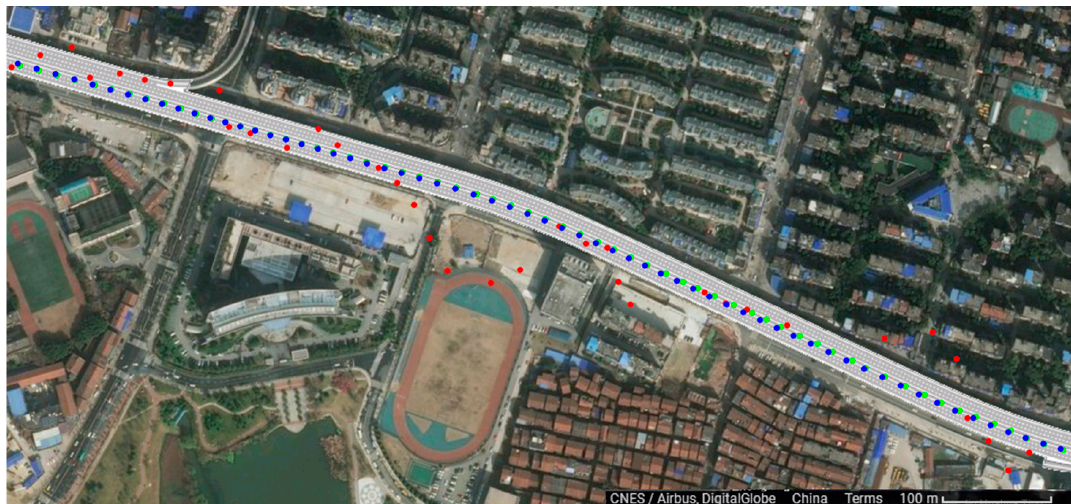
Figure 7. The trajectories of vehicle on roads with noise barrier (the green trajectory uses only satellite positioning, and the red trajectory uses both satellite positioning and inertial navigation, while the blue one is obtained from the POS 620 unit).